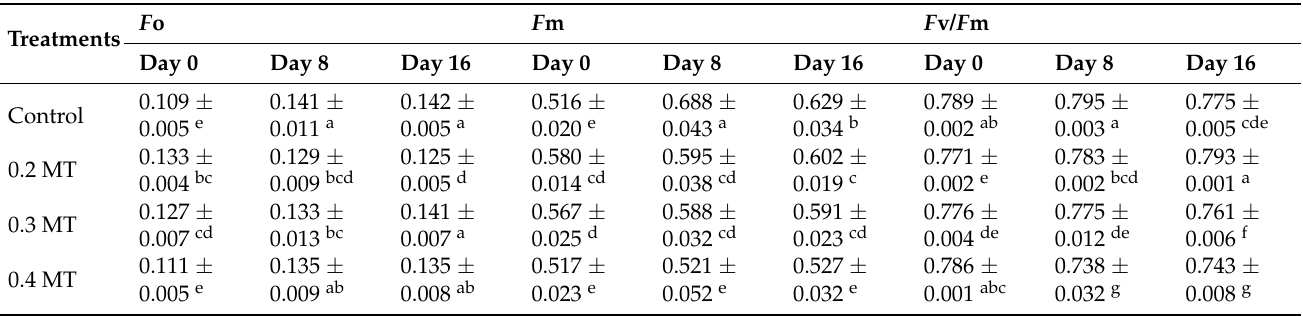
Table 2. Effect of exogenous melatonin on F o, F m, and F v/ F m in tea leaves. F o F Treatments